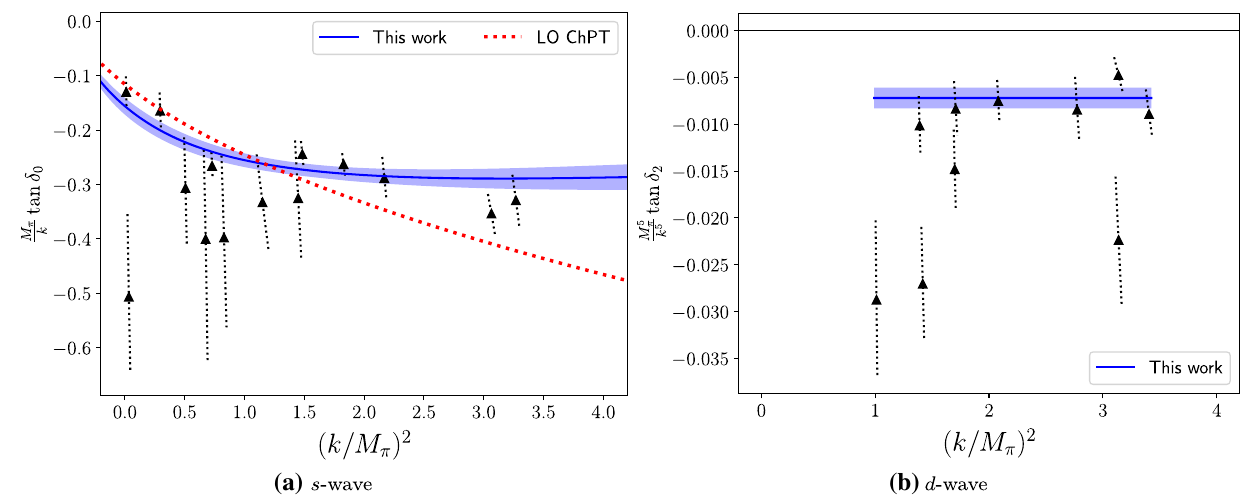
Fig. 9 s - and d -wave phase shift for the ensemble cA2.30.48. For s -wave we use a model that incorporates the Adler-zero, whereas for d -wave we fit to a constant in the region for which we have data. Two points have been omitted in the plot due to the very large errorbars